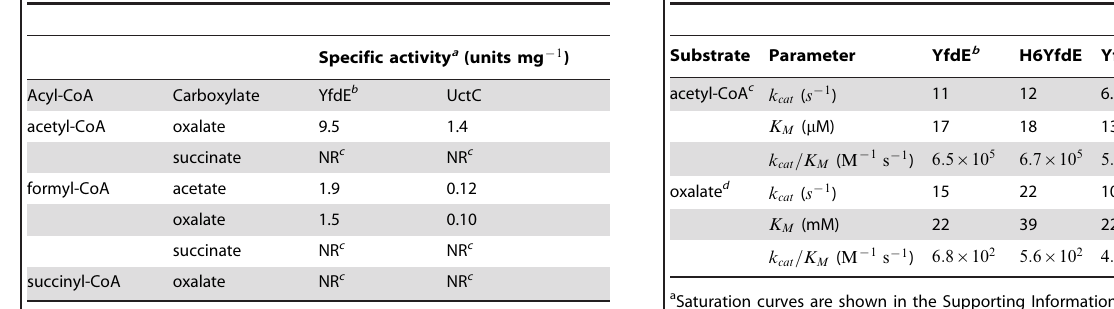
Table 1. Identification of substrates for YfdE and UctC. Table 2. Kinetic parameters for YfdE and UctC.